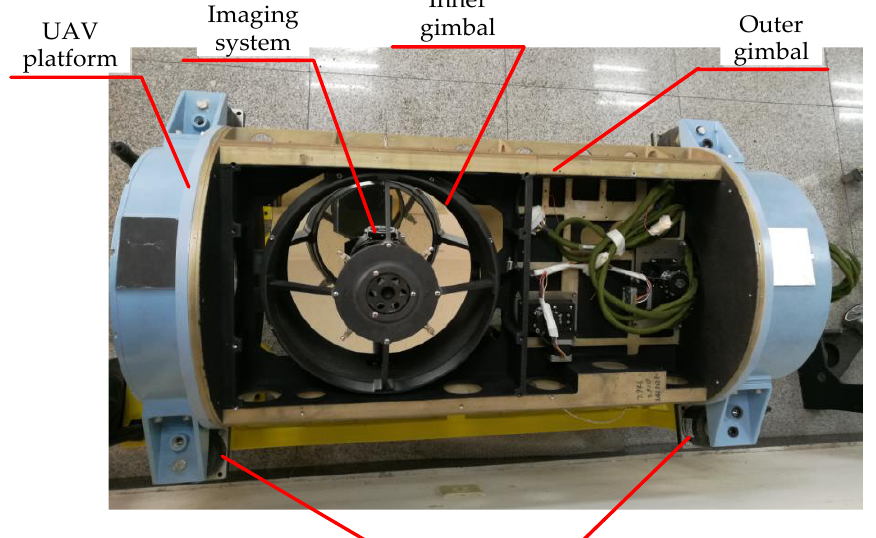
Figure 14. Photograph of the LRORS.